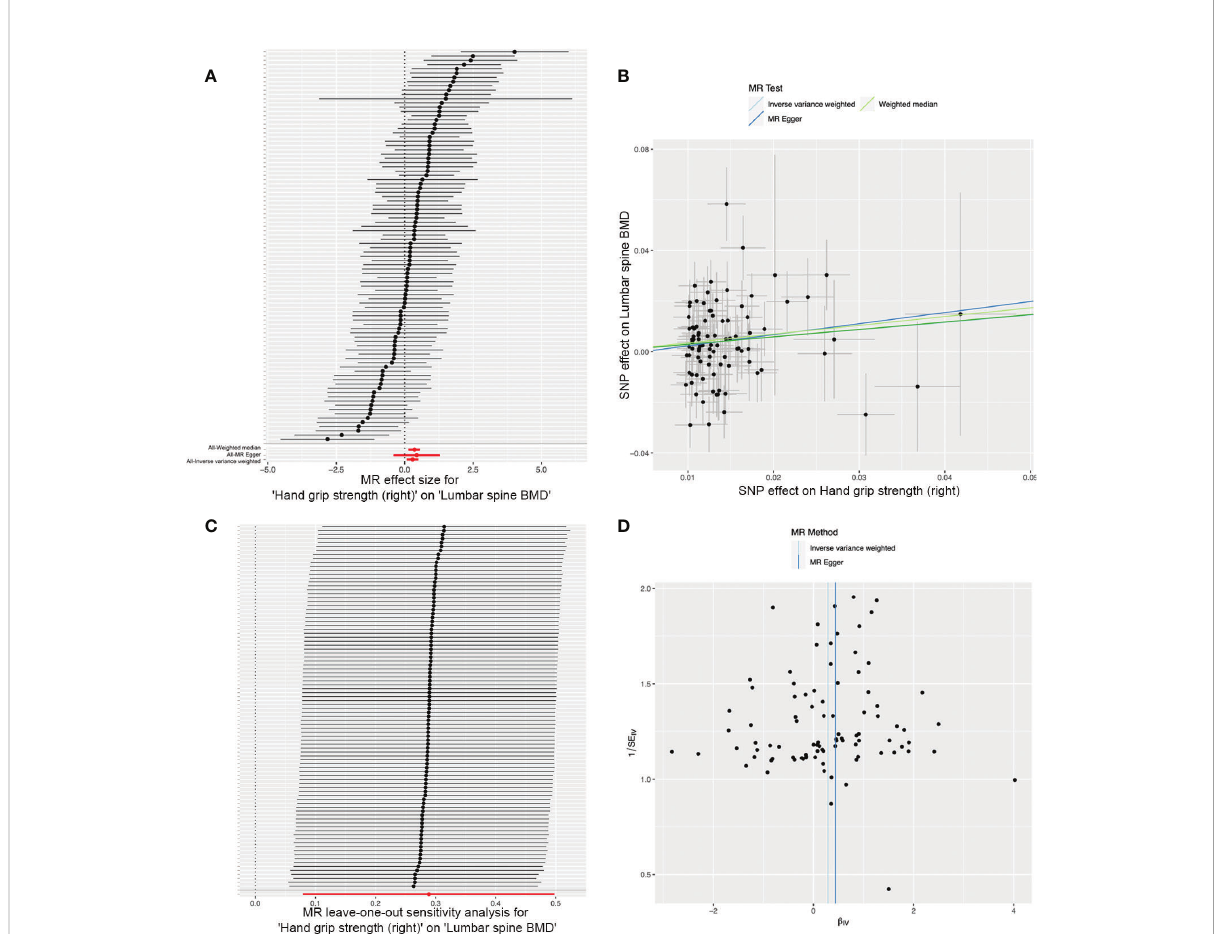
FIGURE 3 Effects of hand grip strength on lumbar spine BMD. (A) Forrest plot. (B) Scatter plot. The slopes of each line represent the causal association for each method. (C) Leave-one-out analysis. (D) Funnel